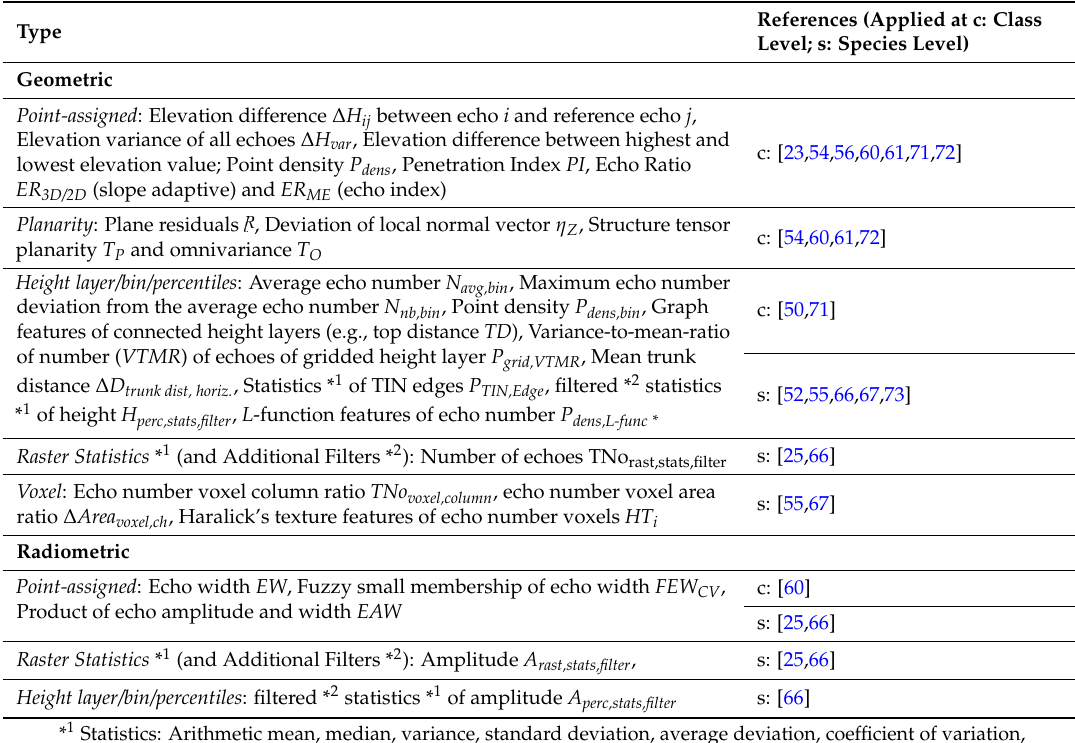
Table 1. Subset features for classification differentiated by geometric and radiometric feature types and related to studies at taxonomic class and species